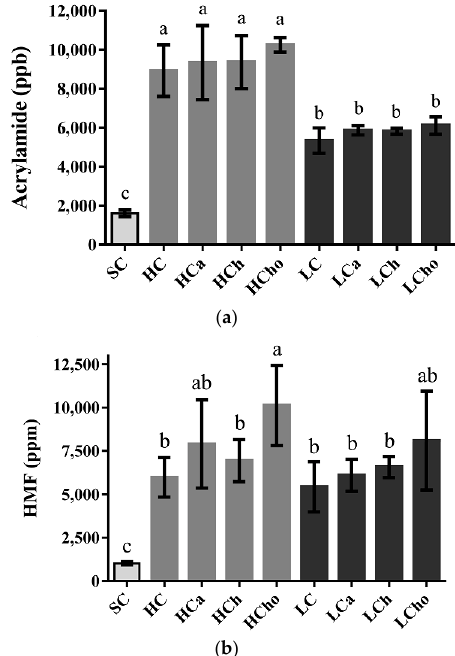
Figure 1. E ff ect of calcium carbonate, chitosan, and chitooligosaccharide on acrylamide ( a ) and hydroxymethylfurfural (HMF) ( b ) formation in brown sugar cookies. a–c Indicate significant di ff erence between di ff erent groups (n = 3; p < 0.05). SC: Sucrose cookie; HC: High acrylamide level of brown sugar in cookie; HCa: HC + calcium carbonate; HCh: HC + chitosan; HCho: HC + chitooligosaccharide; LC: Low acrylamide level of brown sugar in cookie; LCa: LC + calcium carbonate; LCh: LC + chitosan; LCho: LC +